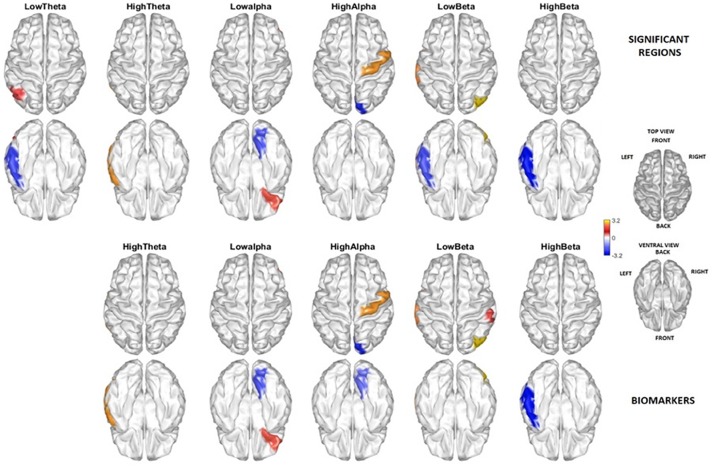
Brain areas and frequencies contributing to the discrimination between PEM and Control. The two rows above show the regions by frequency bands with significant t-test group differences (threshold corrected by permutations) contrasting PEM vs. Control. Highlighted are those areas with a t-test in a range of exceeding (red) and below (blue) the permutation selected threshold for p < 0.05. The two lower rows show the brain regions and frequencies selected as biomarkers. There is a quite good correspondence between the two independent results, except that no biomarker was selected in the Delta band by the classification procedure.